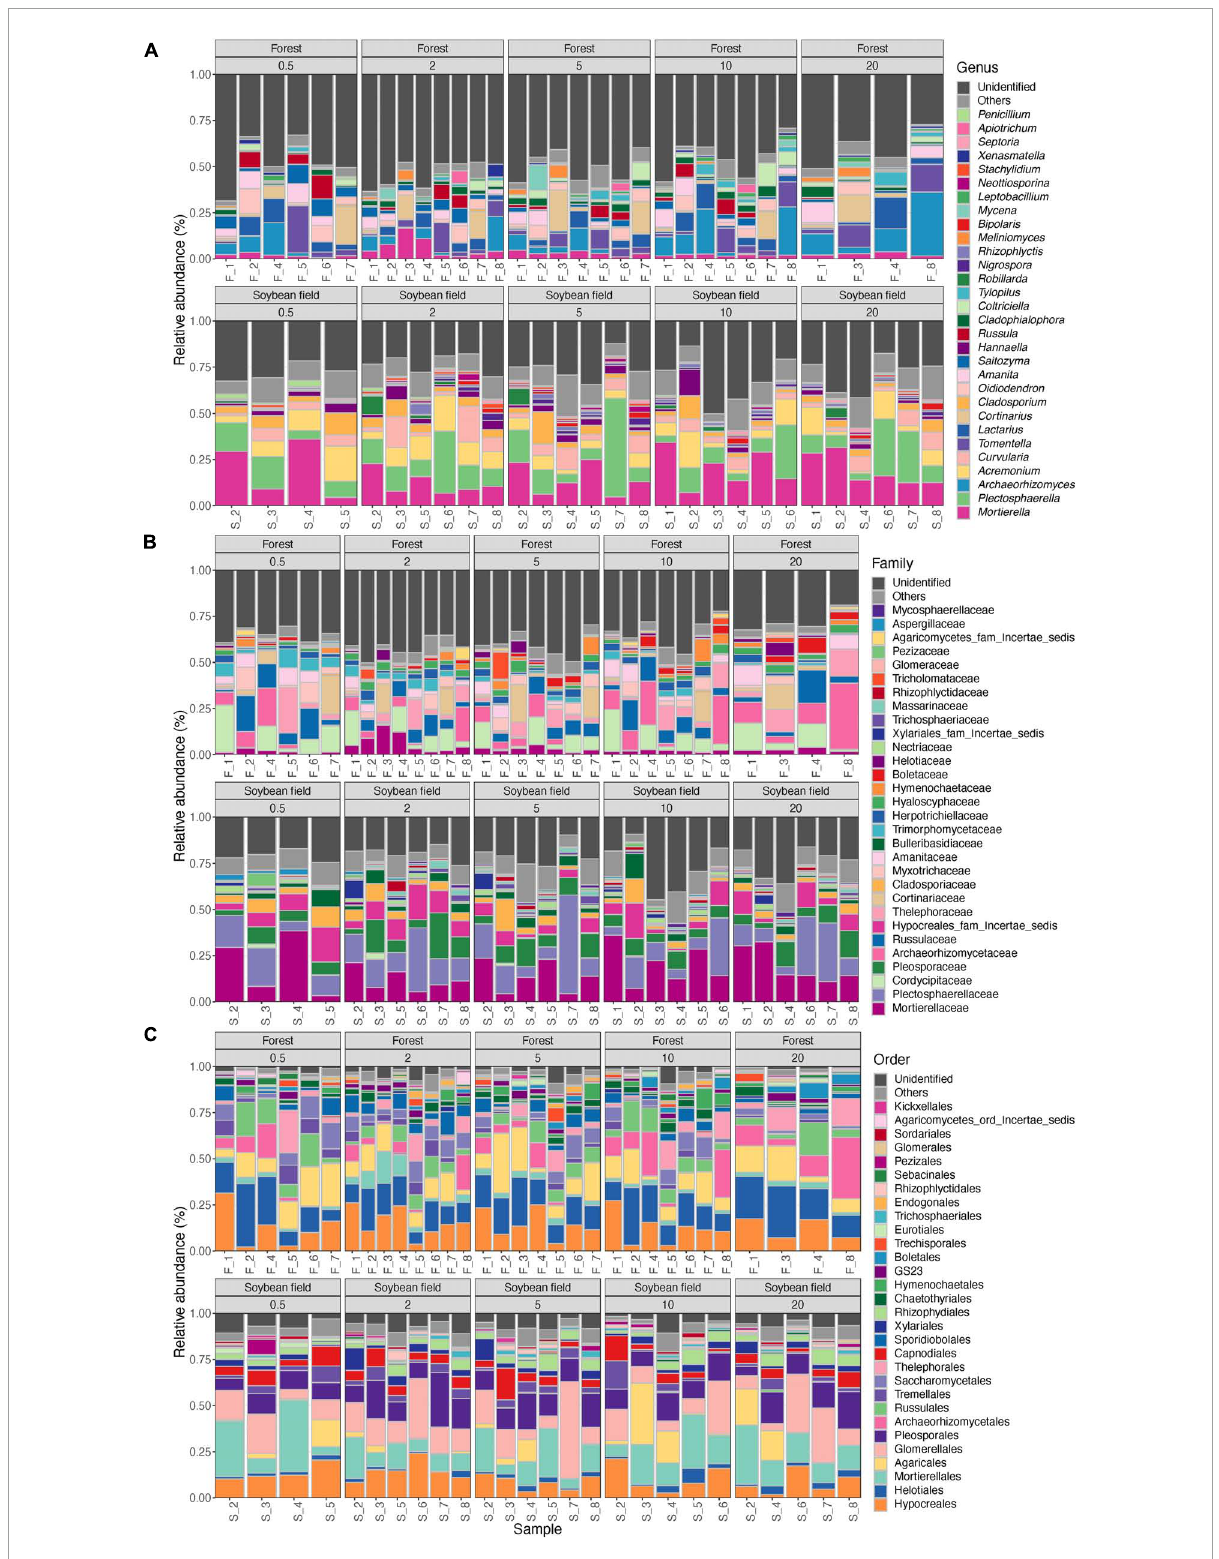
FIGURE3 Community compositions of fungi at the genus (A) , family (B) , and order (C) levels. The alphabets indicating source ecosystem type (“F_,” forest; “S_,” soybean field) are followed by replicate sample numbers. Samples with less than 1,000 sequencing reads were omitted.